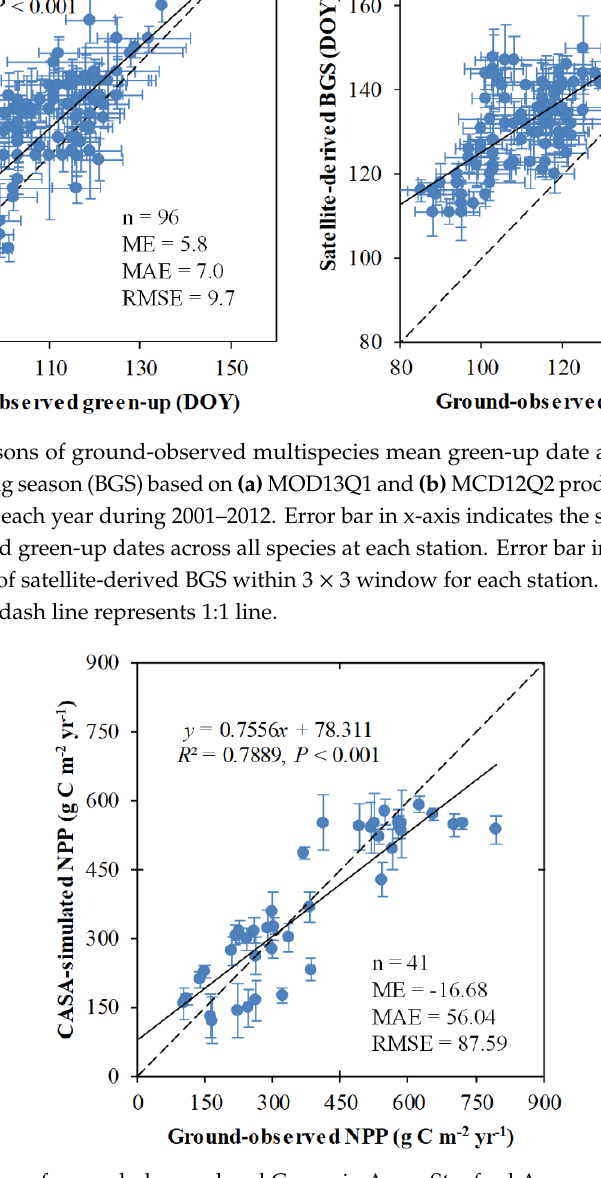
Figure 3. Comparison of ground-observed and Carnegie-Ames-Stanford Approach (CASA)-simulated net primary productivity (NPP). Points represent data for each site in each year during 2001–2012. Error bar in y-axis indicates the standard deviation of CASA-simulated NPP within 3 × 3 window for each station. Solid line represents regression line and dash line represents 1:1 line.